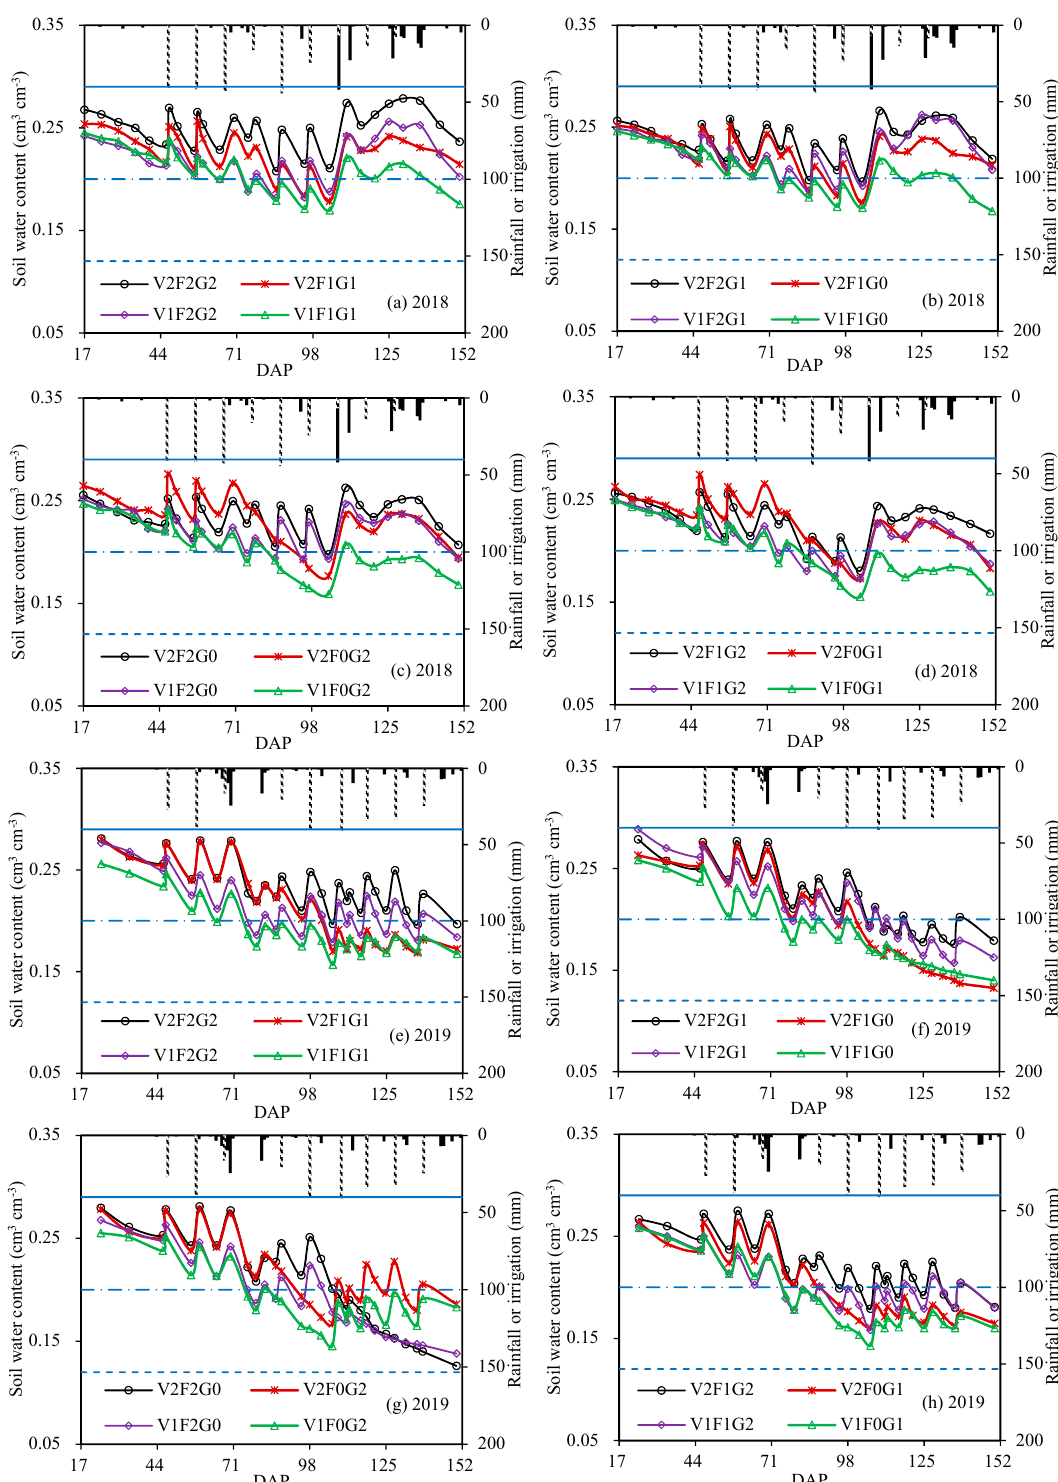
Figure 1. Trends of volumetric soil water content during hybrid maize seed production under different treatments in 2018 ( a – d ) and 2019 ( e – h ). V, vegetative; F, flowering; G, grain-filling; 2, sufficient irrigation; 1, 50% sufficient irrigation; 0, no irrigation; DAP, days after planting; Irrigation of V2F2G2; rainfall; field water capacity; wilting point; lower limit of readily available water, and here considered as 0.20 cm − 3 cm − 3 [40].